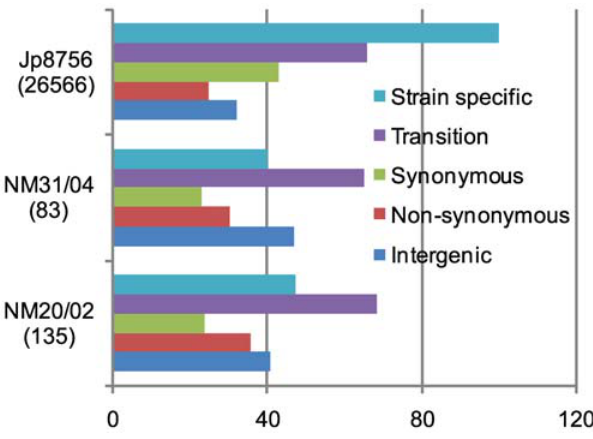
Figure 2. Summary of single nucleotide polymorphisms in M. ulcerans strains. The number in parentheses represents the total number of SNPs in each sequenced strain. The color bars show the distributions of different SNP categories in each strain.